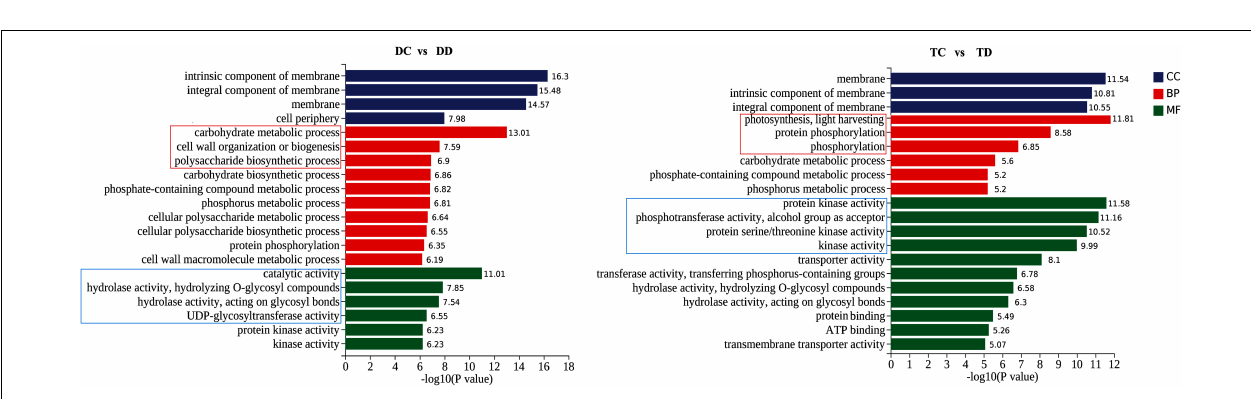
be involved in several kinds of phosphorylation